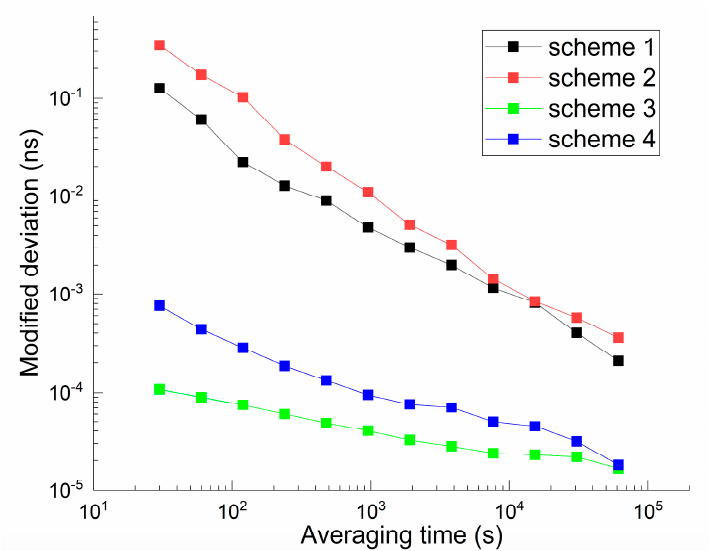
Figure 13. The stability improvement of BDS-3 time transfer with four schemes.